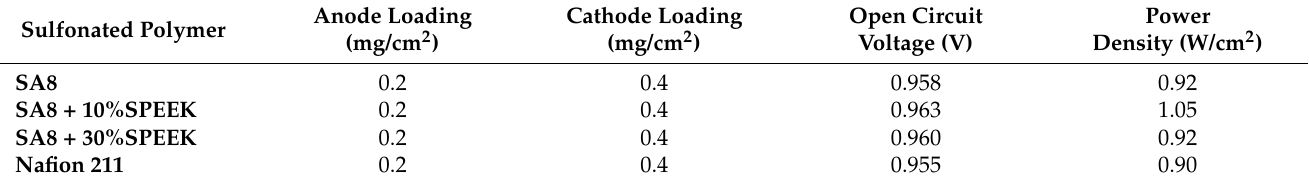
Figure 20. Fuel cell component performance diagram of SA8 blended with sPEEK. Table 6. Component measurement conditions and performance of SA8 blended with